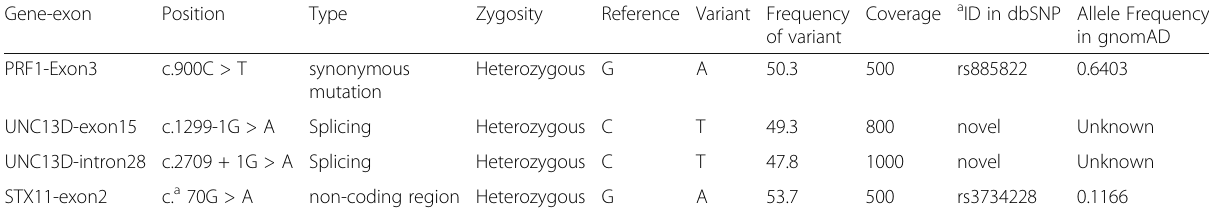
Table 1 Information of mutations detected in patient with amplicon sequencing